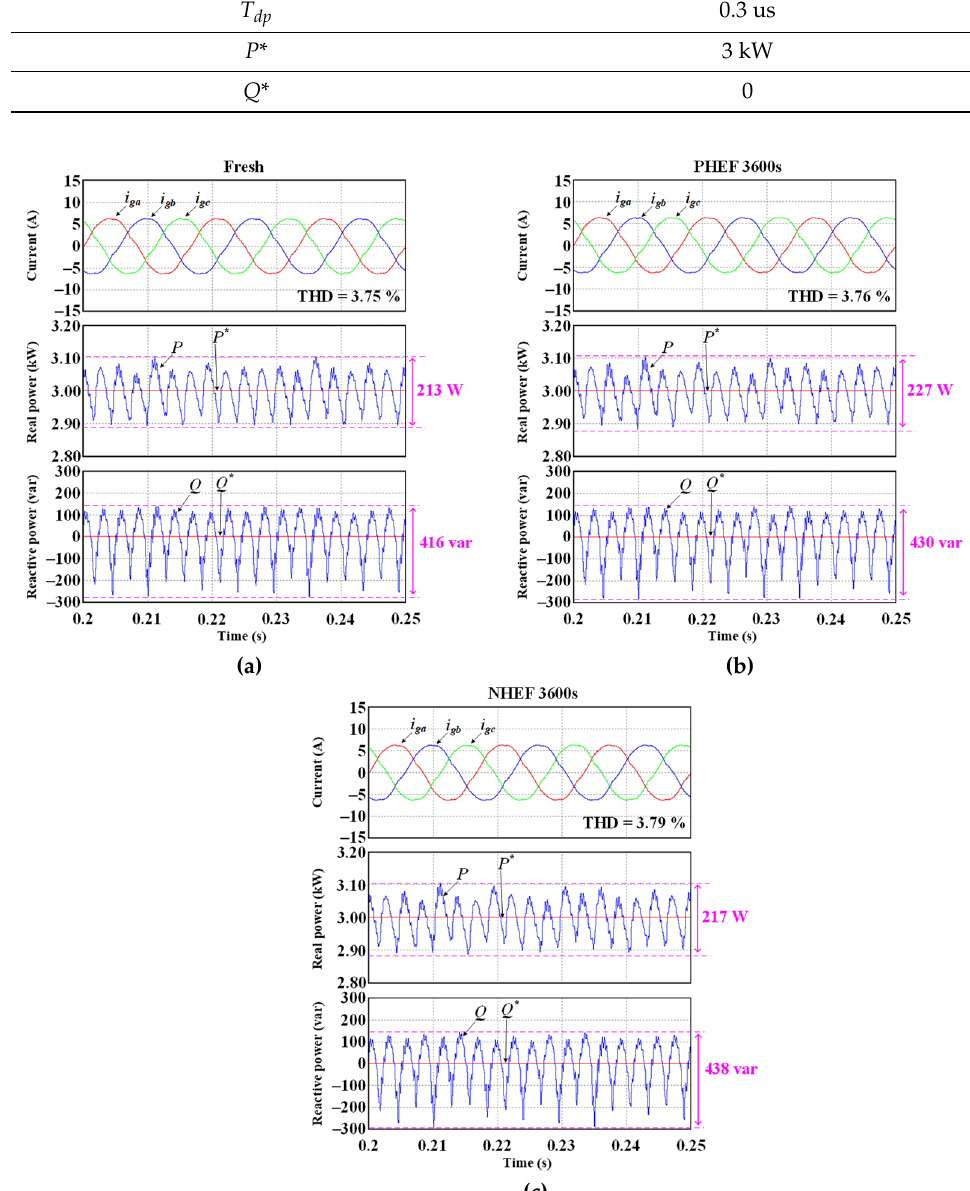
Figure 28. Simulation results of the grid-connected voltage source inverter according to HEF stress: ( a ) fresh condition, ( b ) PHEF stress during 3600 s, and ( c ) NHEF stress during 3600 s.